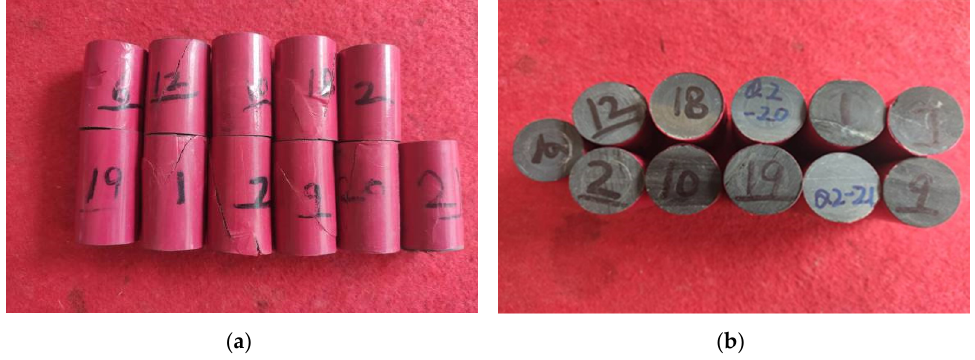
Figure 17. Shale sample after triaxial compression. ( a ) Shale sample, ( b ) cross section of shale sample.